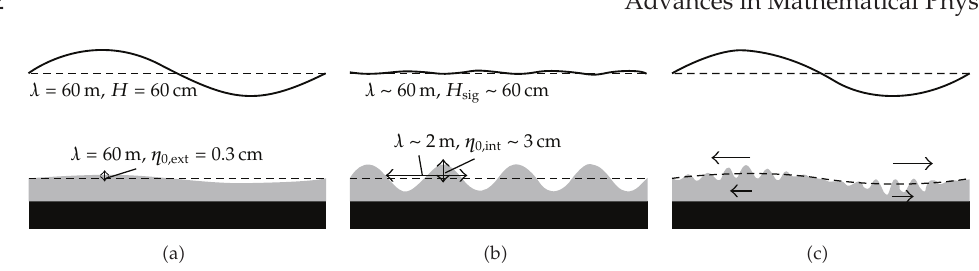
Figure 1: Schematic diagram of the two layer system showing (cid:4) a (cid:5) the external wave mode with the same frequency and wavelength for both the air-water and water-mud interface waves, (cid:4) b (cid:5) the internal wave mode with the same frequency, but much shorter wavelength for the water-mud interface waves, and (cid:4) c (cid:5) the combination of the two. The arrows in panel (cid:4) c (cid:5) indicate shear across the mud water interface, which could lead to a shear instability mechanism to generate the internal mode waves in each half cycle of the surface